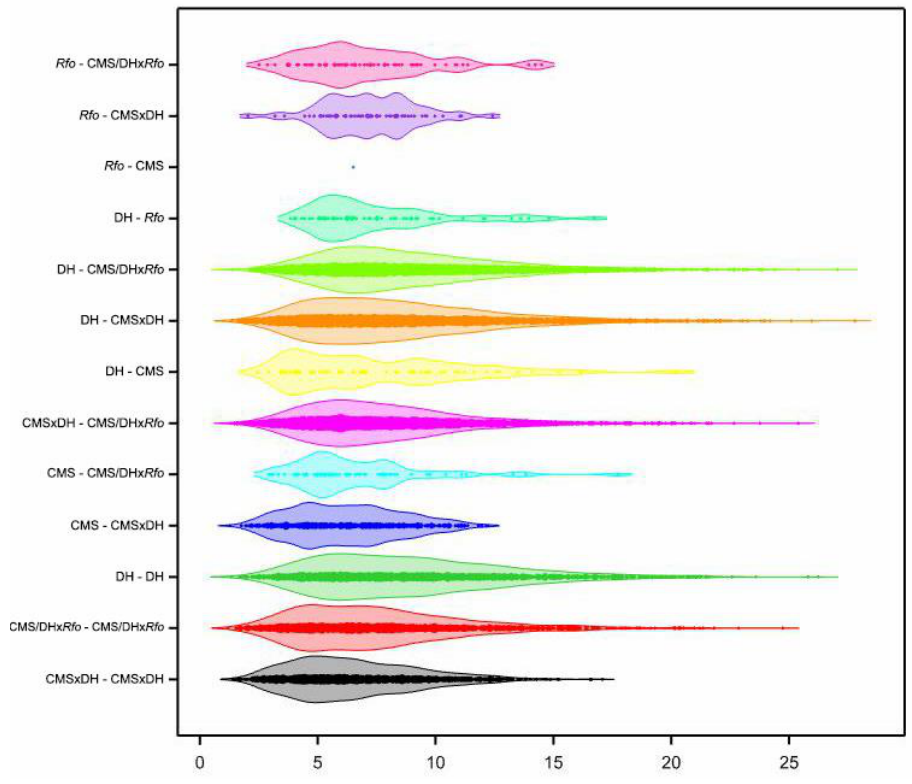
Figure 5. Range of Mahalanobis distances within the studied groups of genotypes in 2016.